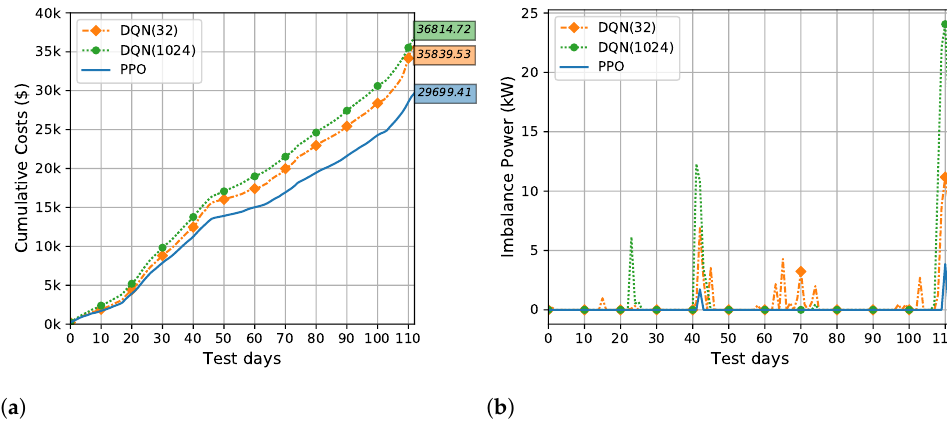
Figure 5. Testing performance of DQN and the proposed approach (PPO). ( a ) Cumulative operating costs on 113 testing days; ( b ) Total imbalance power on each testing